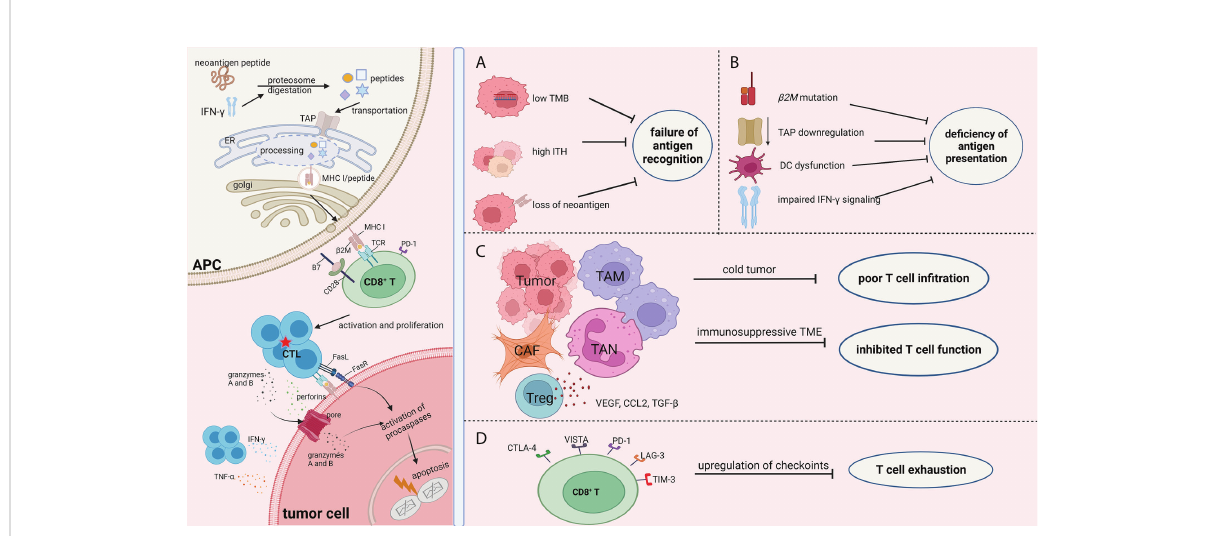
FIGURE 1 Mechanisms of ICB resistance from the perspective of immune response process. The success of ICB immunotherapy lies in the generation and/or reactivation of the population of CTL cells, which are also the central theme of immunotherapy. The left part of the picture depicts the normal immune response procedure which involves antigen processing and presentation, CD8 + T cell priming, and the ef fi cient killing of tumor cells by CTLs. Failure of immunotherapy occurs when the different phases of the cancer immunity cycle are compromised and blocked. There are numerous factors that decrease the effect of the antitumor immunity during the fi ght between tumor cells and immune cells. Regardless of the complexity of the immunotherapy resistance mechanisms, the consequence of these factors can be summarized as (A) failure of antigen recognition; (B) de fi ciency of antigen presentation; (C) poor CD8 + T cells in fi ltration and inhibited activity of CD8 + T cells; and (D) exhaustion of CD8 + T cells. Therefore, we focused on the immune response procedures, especially changes in biological function of CD8 + T cells, with an aim to better understand the resistance mechanisms of ICB. The picture was created with BioRender.com. APC, antigen presentation cell; TAP, transporters associated with neoantigen presentation; ER, endoplasmic reticulum; MHC I, major histocompatibility complex class I; TCR, T cell receptor; CTL, cytotoxic T lymphocytes; TMB, tumor mutation burden; ITH, intra-tumor heterogeneity; DC, dendritic cell; TAM, tumor associated macrophages; CAF, cancer associated fi broblasts; TAN, tumor associated neutrophil; CTLA-4, cytotoxic T-lymphocyte antigen 4; VISTA, V-domain Ig suppressor of T cell activation; LAG-3, lymphocyte activation gene ‐ 3; PD-1, programmed cell death protein -1; TIM-3, T- cell immunoglobulin